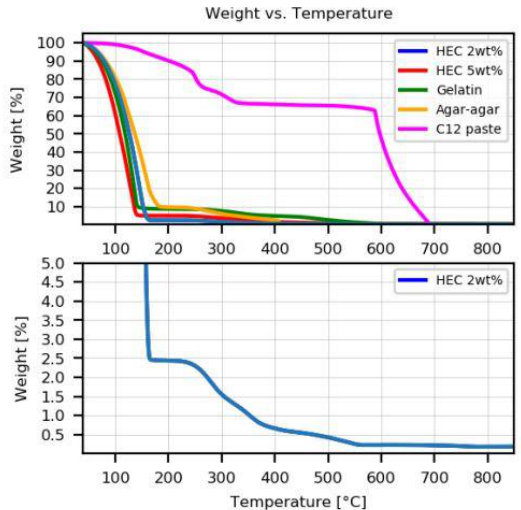
Figure 9. Thermogravimetric analysis (TGA) decomposition traces for the five tested SVM materials in the upper graph and the HEC 2 wt% for weight below 5% in the lower graph. Table 3. Liquid content, bulk decomposition temperature and remaining weight at 62 °C for the SVM samples.